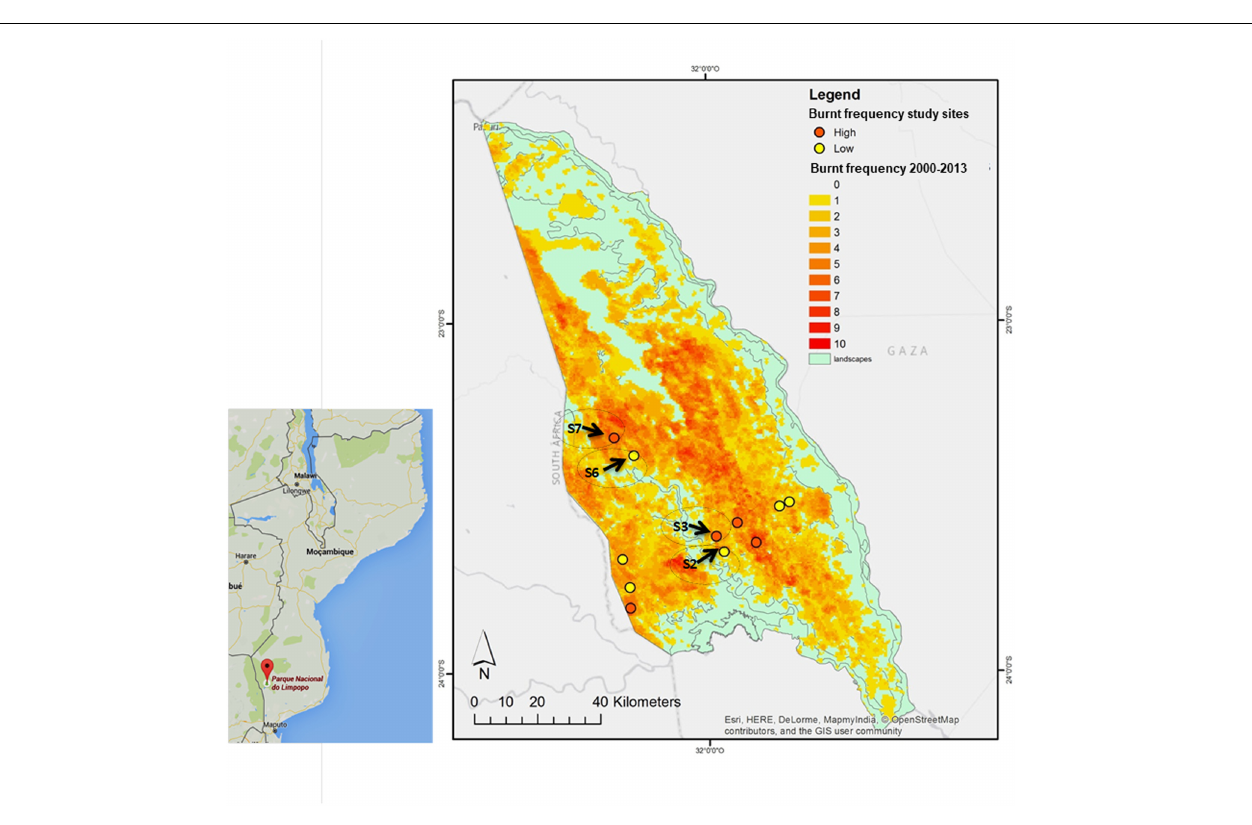
to avoid oxidation and degradation of extracted metabolites by reactions with atmospheric air components, and stored at − 80 ◦ C prior to derivatization and GC-TOF-MS analysis.